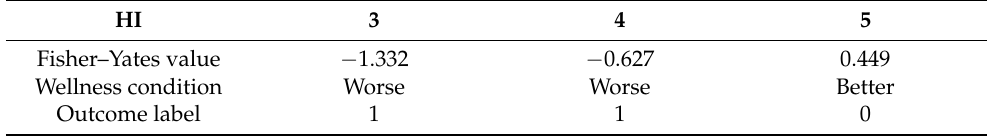
Table 3. An illustration of output labels via Fisher–Yates